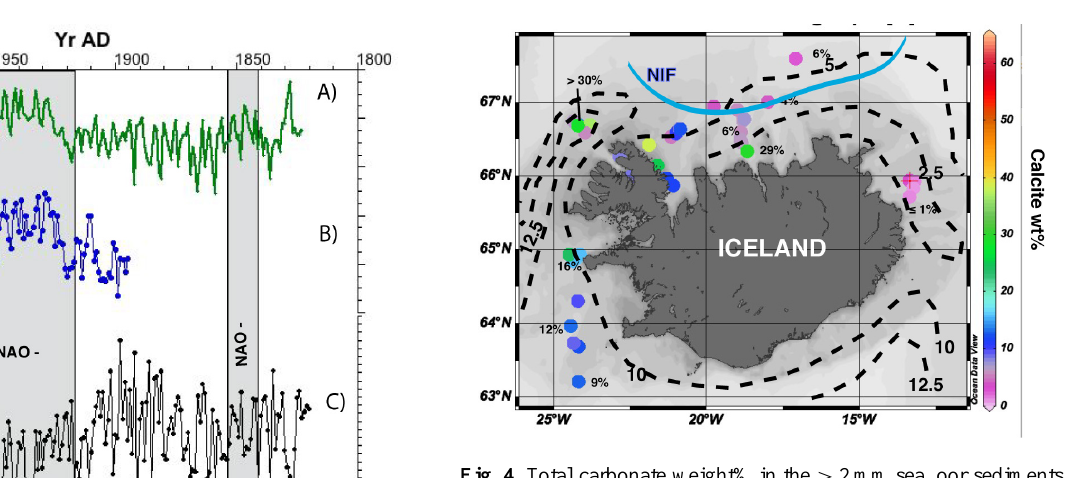
Fig. 4. Total carbonate weight% in the > 2mm seafloor sediments around Iceland (colored circles and black numbers) (i.e. 12%), and the index of vertical mixing dashed black lines show the (Stefansson and Olafsson, 1991) (units see text) means for 20 May–15 June, 1972–1984. The heavy blue line shows the average position of the North Iceland Front (NFI)(Belkin et al.,